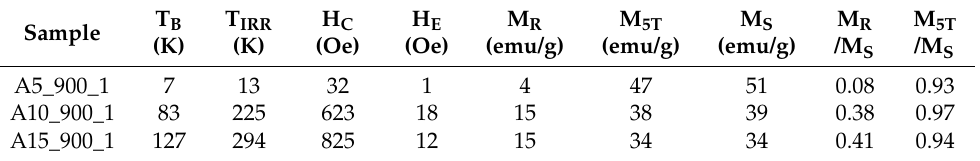
Table 1. Magnetic parameters for the 5 wt%, 10 wt% and 15 wt% CuFe 2 O 4 -SiO 2 nanocomposite aerogel samples. Relevant parameters are indicated as T B (blocking temperature), T IRR (irreversibility temperature), H C (coercivity), H E (exchange bias), M R (remanent magnetization, M 5T (maximum magnetization, M S (saturation magnetization). Hysteresis loops were recorded at 5 K. Values were determined according to what was reported in the Materials and Methods section. Sample